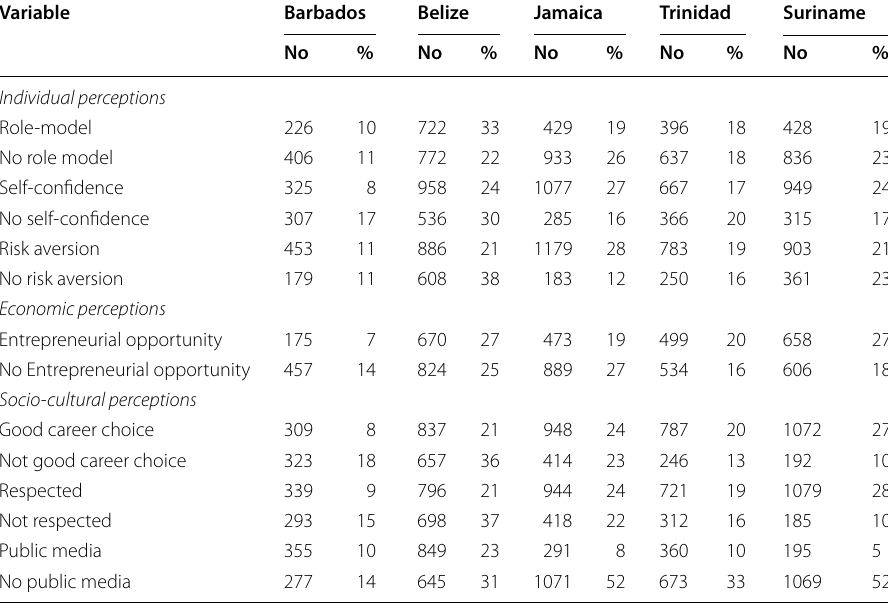
Table 4 Perceptions by country, number of persons and